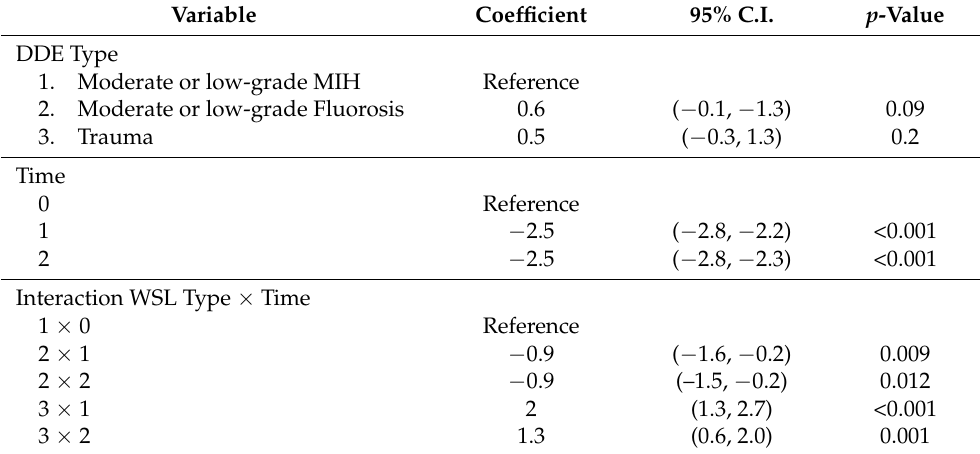
Figure 7. Shiff air index levels predicted by repeated measures (three timepoints) restricted maxi- mum likelihood mixed model.